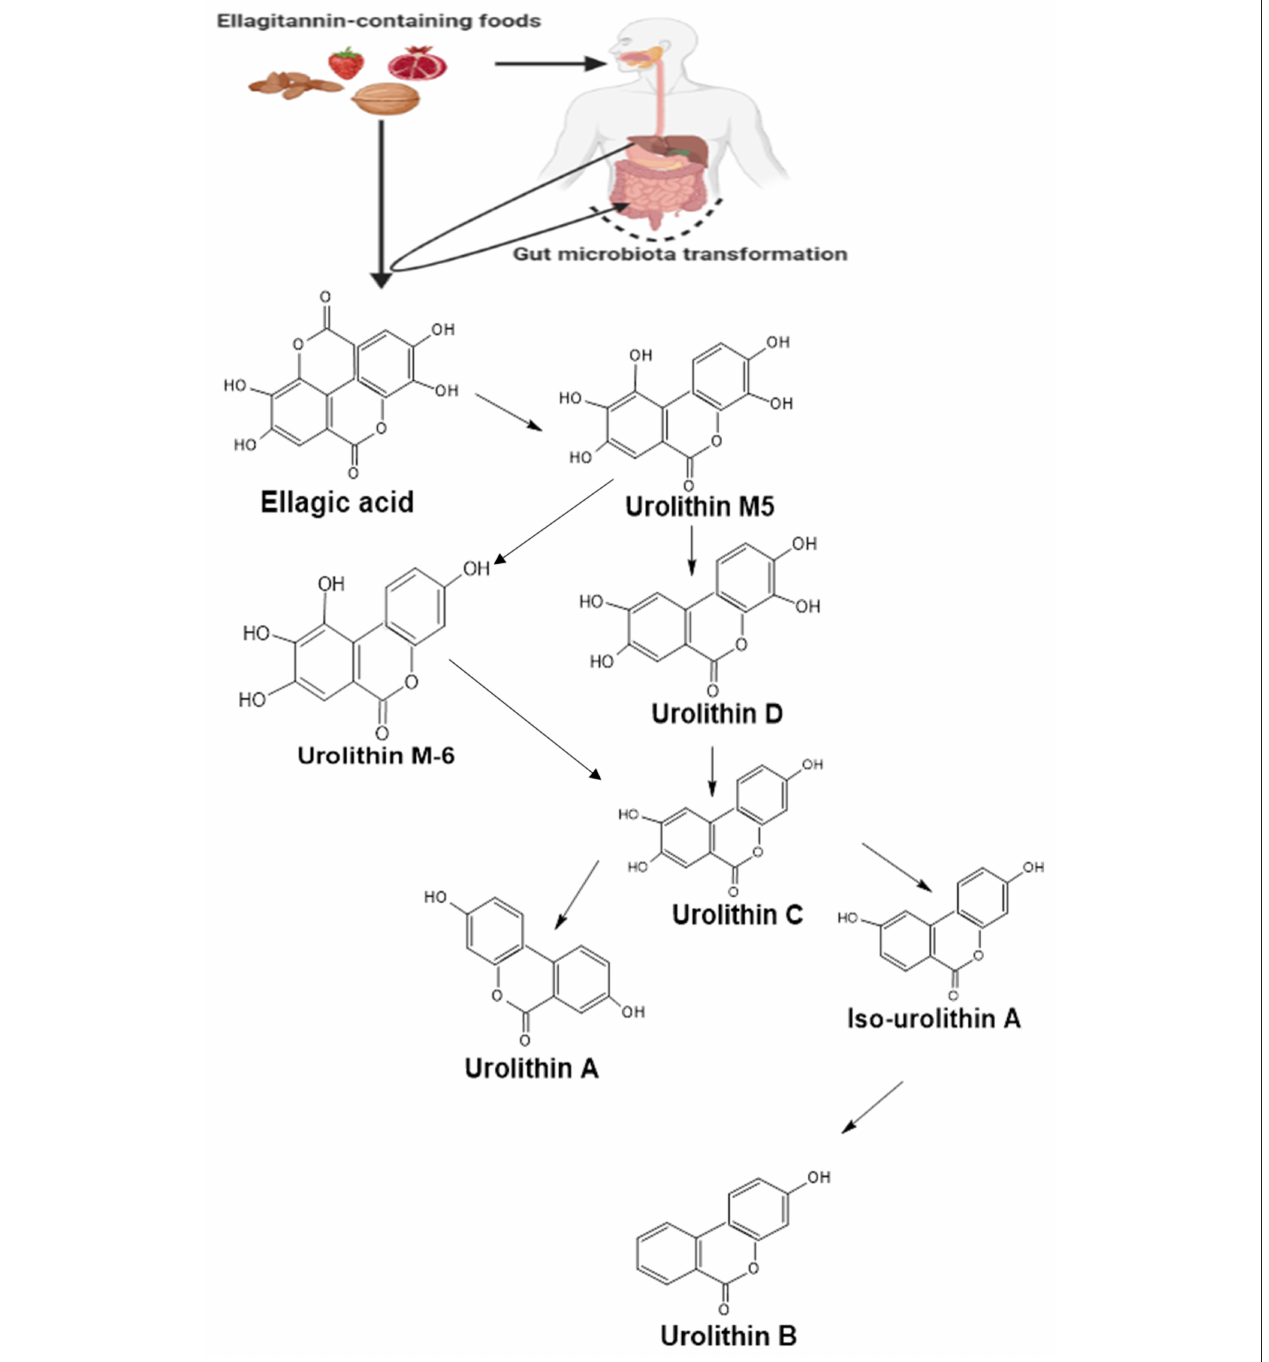
FIGURE 1 | A summarized pathway for the formation of urolithins from ellagitannin and ellagic acid in the gut. Following the ingestion of food containing ellagitannins, they are hydrolyzed in the stomach to yield ellagic acid. The ellagic acid then undergoes series of transformations by the gut microbiota forming different urolithin molecules. Created with ChemSketch and